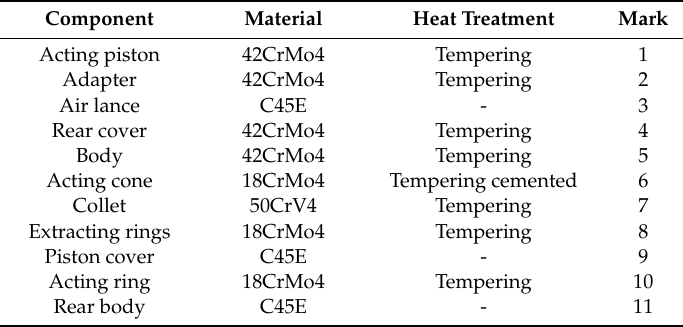
Table 1. Materials of the expanding mandrel.